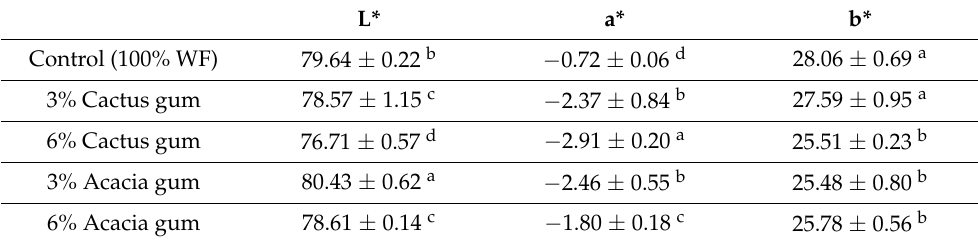
Table 4. Color parameter of the